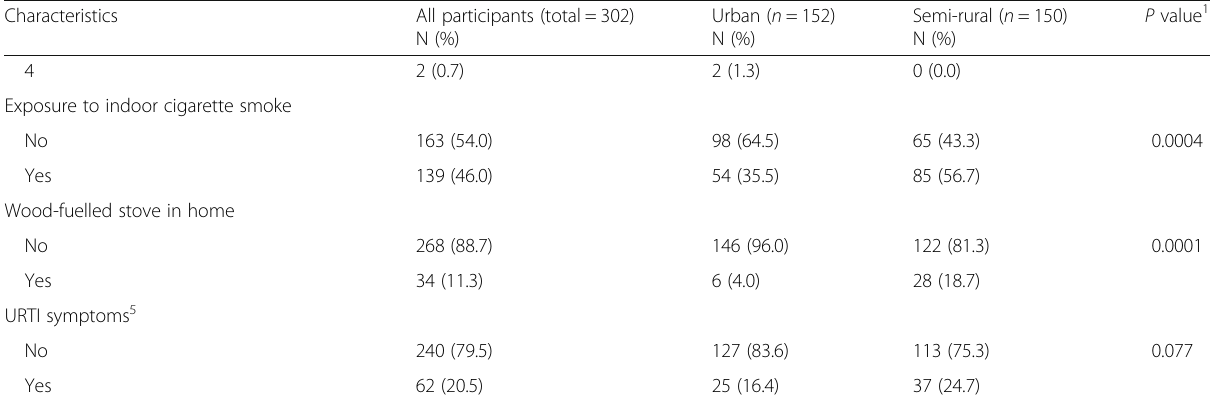
Table 1 Characteristics of study participants (Continued)